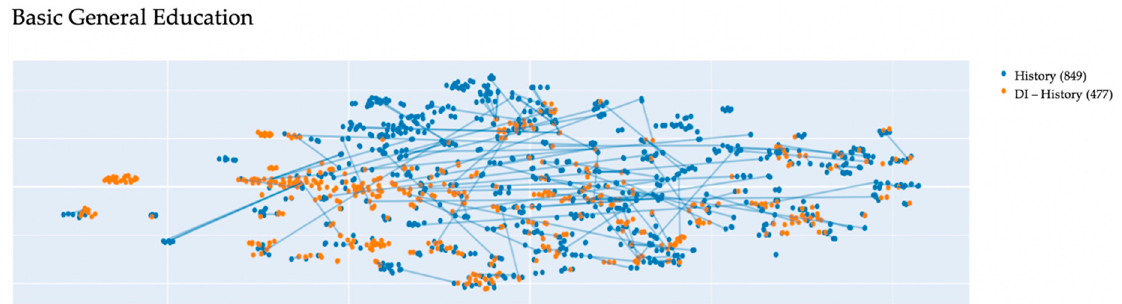
Figure 5. Semantic correlations between the didactic item titles in the Topical Framework and the lesson script titles in the subject History. Information 2019 , 10 , x FOR PEER REVIEW